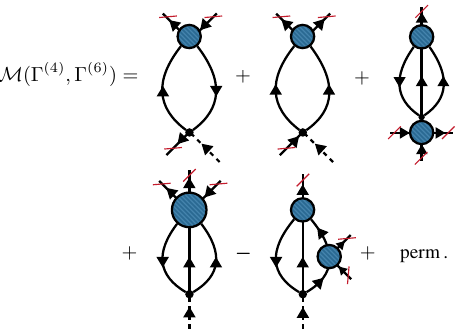
Figure 2: Loop-contributions to the evolution equation of Γ ( 4 ) involving 1PI four- and six-vertices in a translation invariant system. Note that all external propagators (solid lines) are amputated and permutations of legs are implied. For the underlying analytical expressions, see